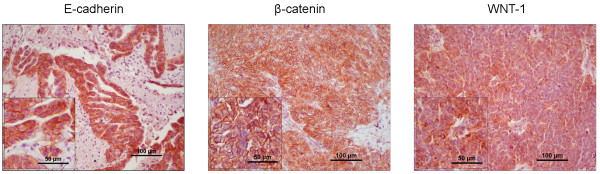
Expression of E-cadherin, β-catenin and WNT-1 in ovarian cancer. E-cadherin displayed strong membranous and cytoplasmic immunoreactivity in cancer cells Strong membranous, moderate cytoplasmic and lack of nuclear expression of β-catenin was observed in tumour tissue. In ovarian carcinoma, there was strong WNT-1 immunoreactivity.